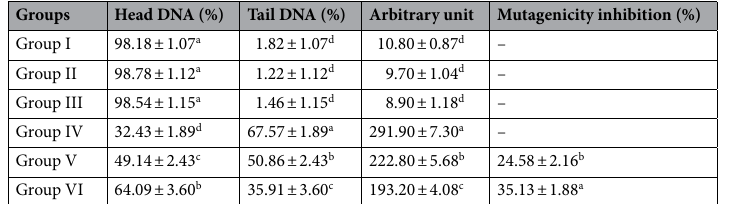
Table 6. Detection of the effects of pendimethalin and curcumin applications on DNA by comet assay. Group I: tap water (control), Group II: 5 mg/L curcumin, Group III: 10 mg/L curcumin, Group IV: 12 mg/L pendimethalin, Group V: 12 mg/L pendimethalin + 5 mg/L curcumin, Group VI: 12 mg/L pendimethalin + 10 mg/L curcumin. Data are shown as mean ± standard error of means (SEM). The averages shown with different letters in the same column are statistically significant ( P < 0.05).